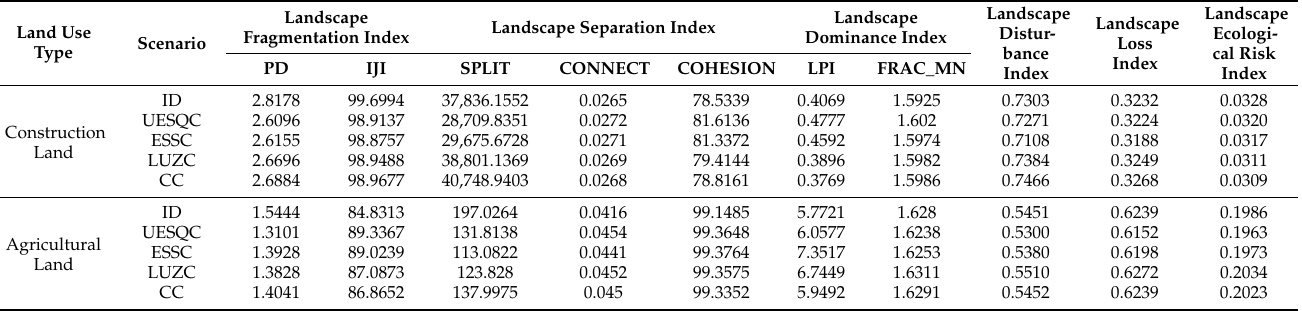
Table 10. Indicators of Landscape Ecological Risk in Changde under Different